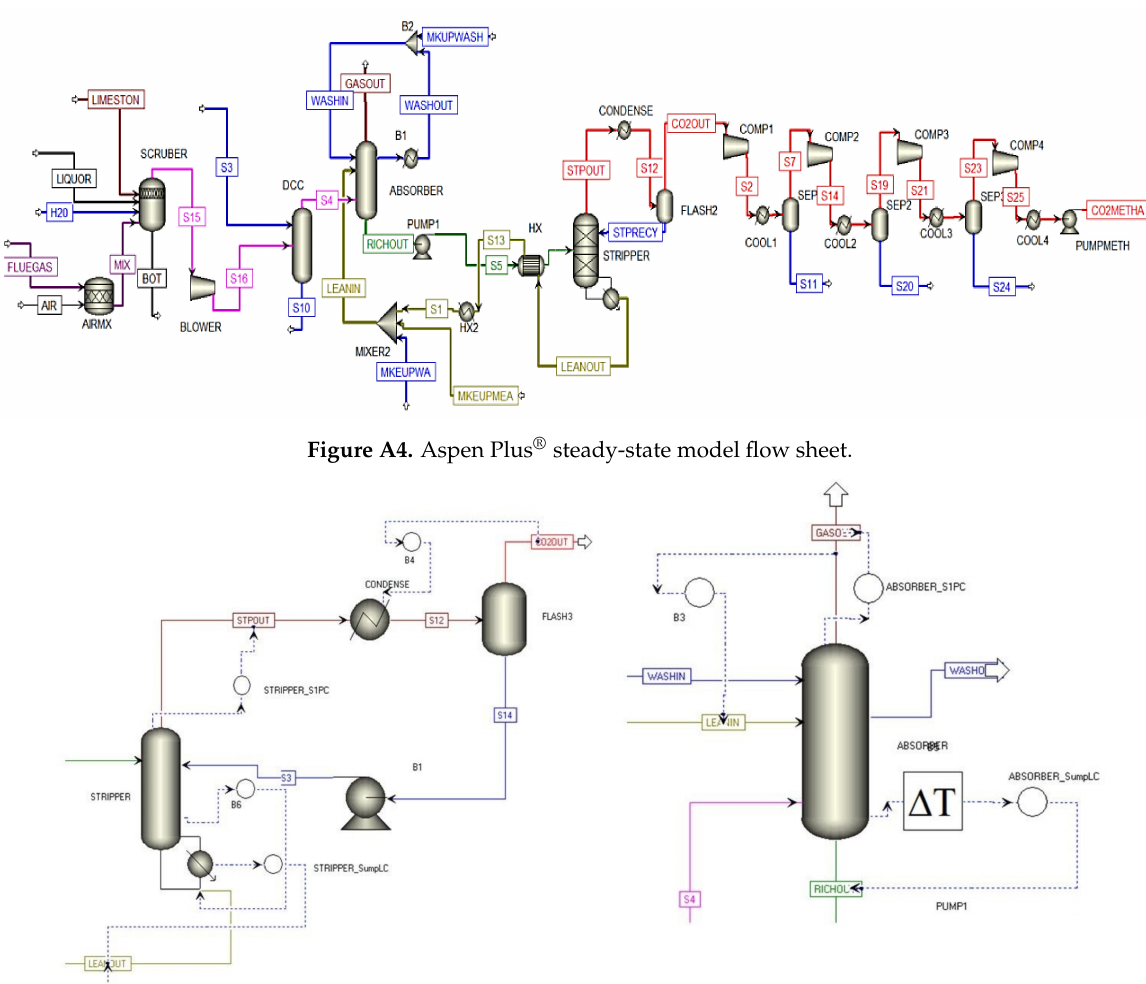
Figure A5. Aspen Plus ® Dynamics control scheme as described in Section